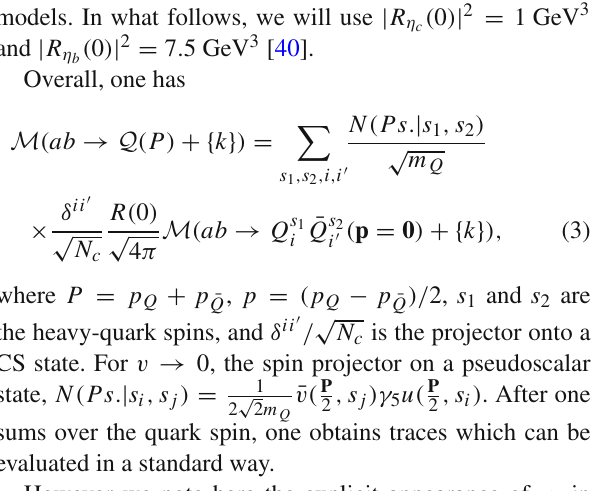
Fig. 1 Representative diagrams contributing to η Q hadroproduction via CS channels at orders α 2 s ( a ), α 3 s ( b – f ). The quark and antiquark attached to the ellipsis are taken as on-shell and their relative velocity v is set to